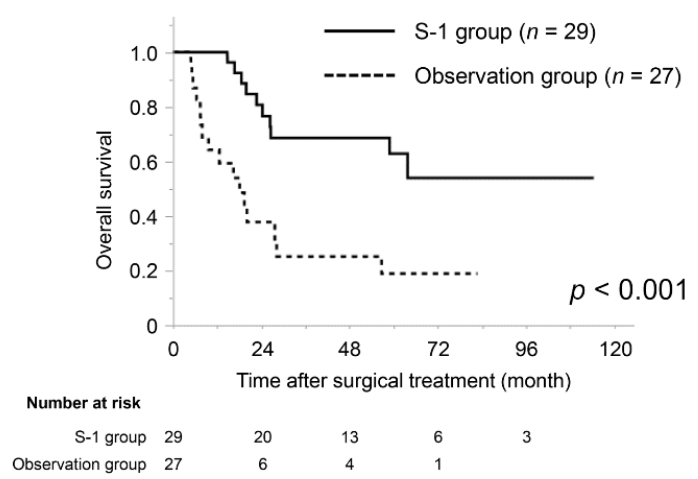
Figure 3. Kaplan–Meier curves for the overall survival of matched cohort patients with perineural invasion. The overall survival of the S-1 group was significantly better than that of the observation group ( p < 0.001).